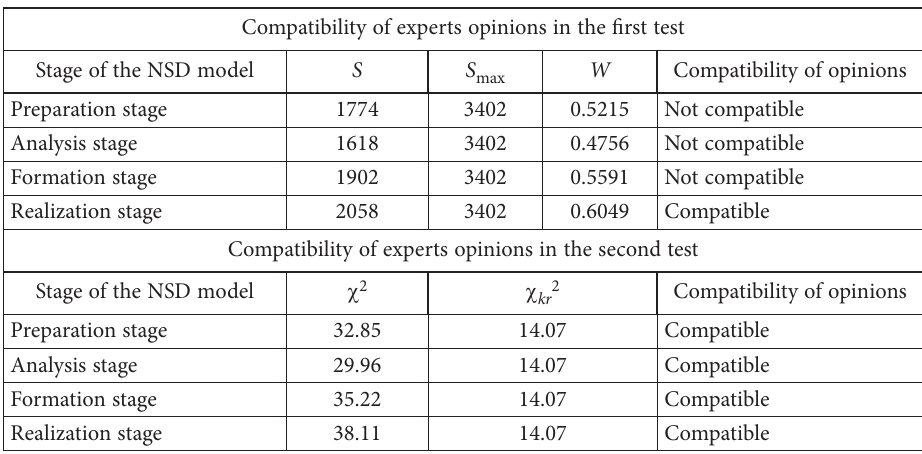
Table 5. Results of compatibility of Danish experts’ opinions (source: compiled by the